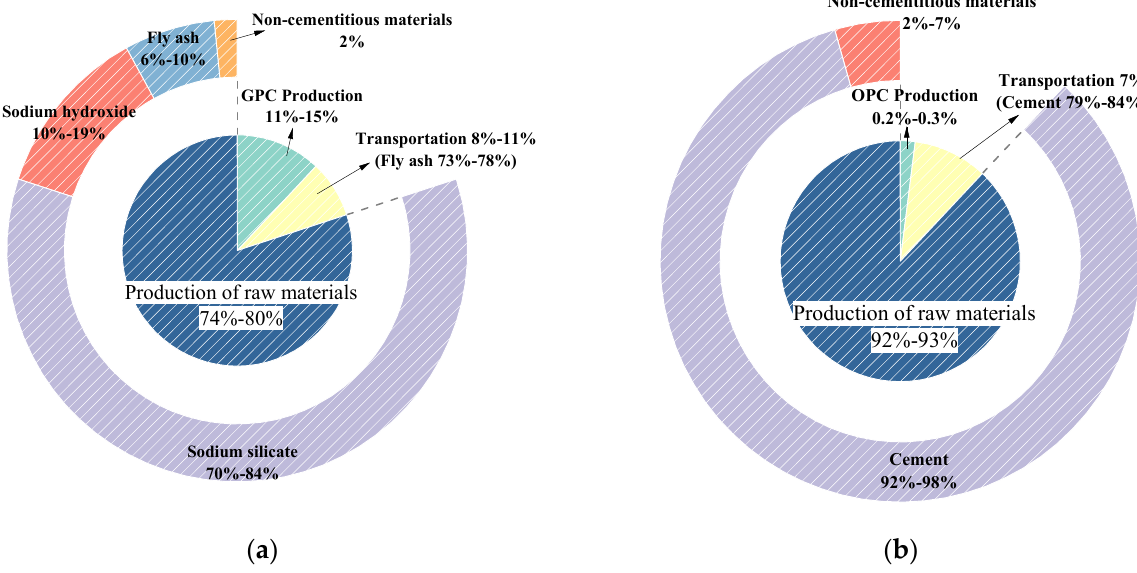
Figure 3. Distributions of CO 2 emission of ingredients and phases of concrete:( a ) GPC; ( b ) OPC. Compared with the CO 2 emissions of GPC and OPC concrete, the minimum emission of GPC with 40 MPa is 260.14 kg CO 2 /m 3 , and the maximum is 336.54 kg CO 2 /m 3 . How- ever, OPC concrete with 40 MPa showed a variation from 334.90 to 412.58 kg CO 2 /m 3 , which is higher than GPC. The highest CO 2 emission was recorded in C60 and C70 of GPC (333.28 kg CO 2 /m 3 and 305.38 kg CO 2 /m 3 , respectively), which is significantly lower than the minimum in OPC concrete with the same compressive strength (405.26 kg CO 2 /m 3 ). CO 2 emissions from GPC at 40 MPa, 60 MPa, and 70 MPa are reduced by 20.48%, 27%, and 34.6% respectively compared to OPC. It seems that the higher the compressive strength of the geopolymer concrete, the more significant the CO 2 reduction effect. In gen- eral, the production of GPC has a lower CO 2 emission than that of OPC concrete. The results show that for the same compressive strength, GPC can reduce emissions by up to 166.36 kg CO 2 /m 3 compared to OPC, which is approximately 62.73% of its carbon emis- sions. Compared with the results shown in Figure 2, it can be seen that the CO 2 emissions increased continuously with increasing the compressive strength for OPC. However, for GPC, the CO 2 emission showed a slight correlation with compressive strength [17], which might be attributed to the fact that the compressive strength and CO 2 emission of OPC concrete is greatly affected by the amount of cement. Therefore, it can be concluded that GPC can effectively improve the environmental impact without compromising its strength. For geopolymer, the maximum impact on the environment is the alkali activator [18]. Salas [19] showed that the higher the compressive strength, the higher the environ- mental impacts of higher activator quantities. According to the distributions of CO 2 emis- sions in GPC and OPC shown in Figure 2, it can be indicated that the relationship between the different phases is Csc >> Cc > Cys for GPC, while for OPC concrete, it is Csc >> Cys >> Cc. The CO 2 emission of the production of raw materials is the largest for both. In Figure 3a, the CO 2 emission in the raw materials production process of GPC reaches 74–80% of the total emissions, in which sodium silicate takes the most significant proportion, accounting for about 70–84%, which is followed by sodium hydroxide, mak- ing up around 10–19%. The commonality in mixes with the lowest CO 2 emission is in us- ing less alkali activator solution. Therefore, it is suggested to employ sustainable produc- tion technology of alkali activator solution and control its usage. Bajpai [20] proposed that silica fume, instead of sodium silicate, can further reduce the environmental impact of geopolymer concrete. On the other hand, considering that the economic value allocation procedure is used to distribute the environmental impact of fly ash, CO 2 emission of fly